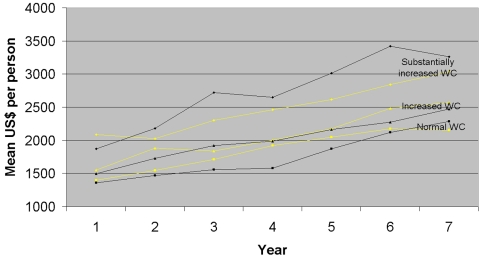
Mean annual health care cost by WC categories (men black, women light).